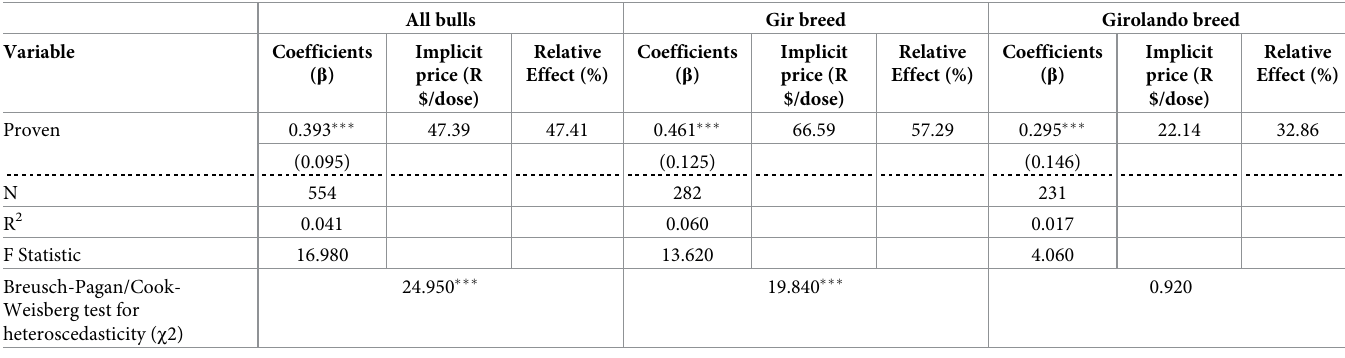
Table 3. Estimated parameters and implicit attribute prices for semen of dairy bulls. All bulls Gir breed Girolando